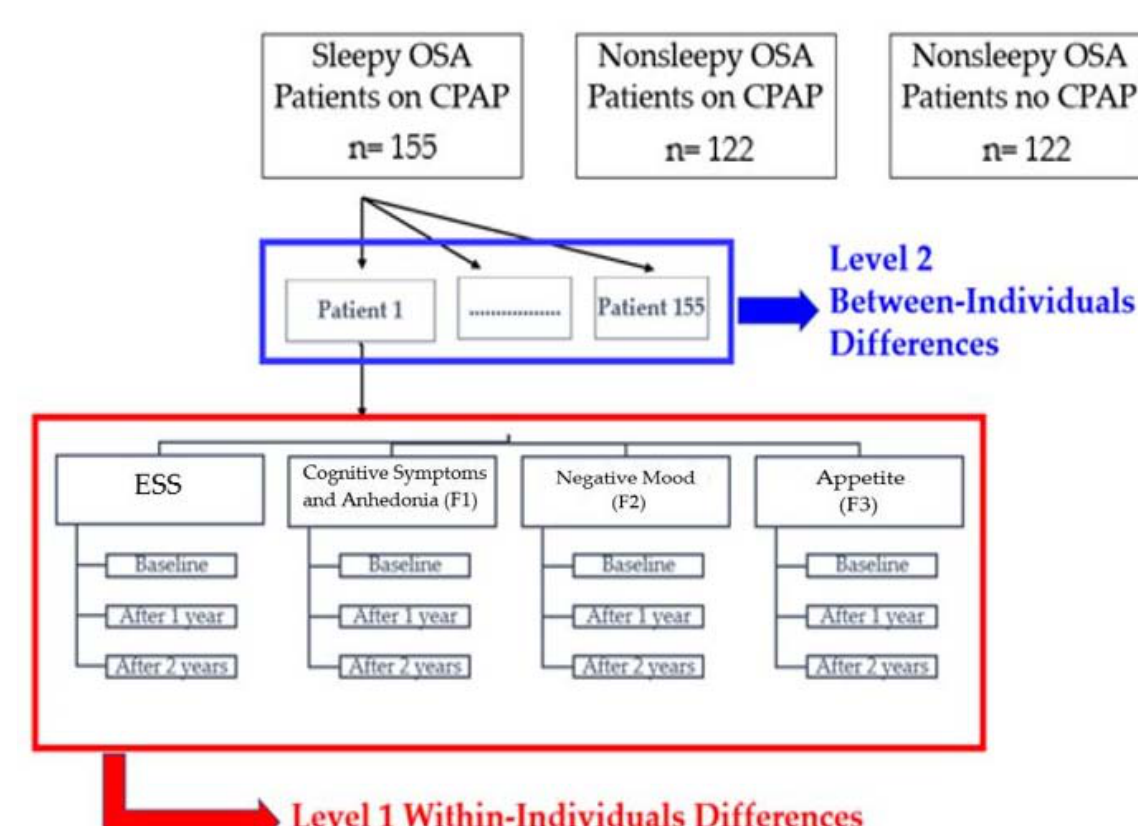
Figure 2. A two-level linear mixed model of the study design. CPAP, continuous positive airway pressure; ESS, Epworth Sleepiness Scale; OSA, obstructive sleep apnea.